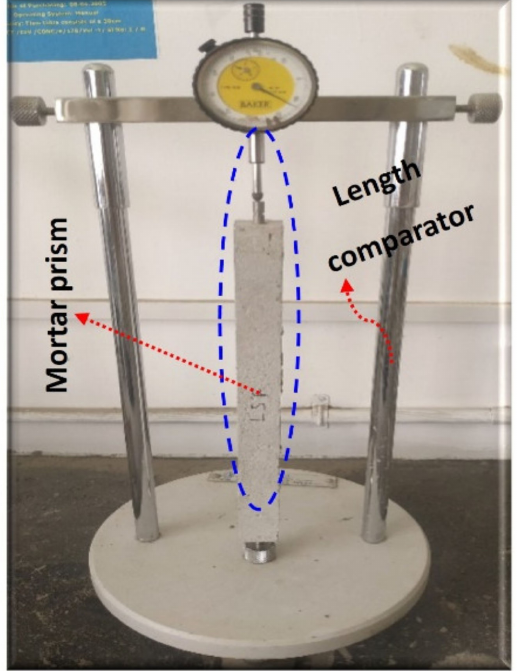
Figure 4. Length comparator test